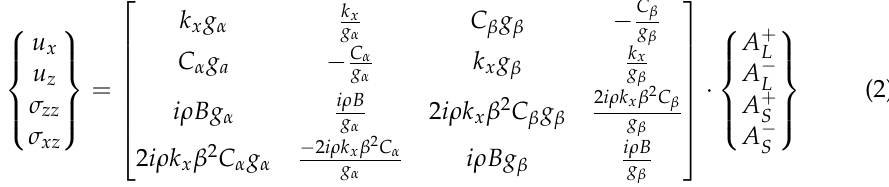
Here, the amplitude of the ultrasonic wave traveling in the depth direction of the thin Here, (cid:1863) (cid:3051) and (cid:1863) (cid:3053) are the wavenumber in the x -direction and z -direction, respec- film structure is represented by + subscript, and that traveling in the opposite direction tively, (cid:1827) (cid:3013) is the amplitude of the longitudinal wave, and (cid:1827) (cid:3020) is the amplitude of the trans- is represented by the—subscript. The variables, C α , C β , g α , g β and B , are arbitrarily designated abbreviations for convenience of calculation and are expressed as follows. verse wave. In the Cartesian coordinate system, the relationship between the displace- ment, stress, and amplitude in the propagation direction ( x -axis) and the depth direction ( z -axis) is as shown in Equation (2) below.